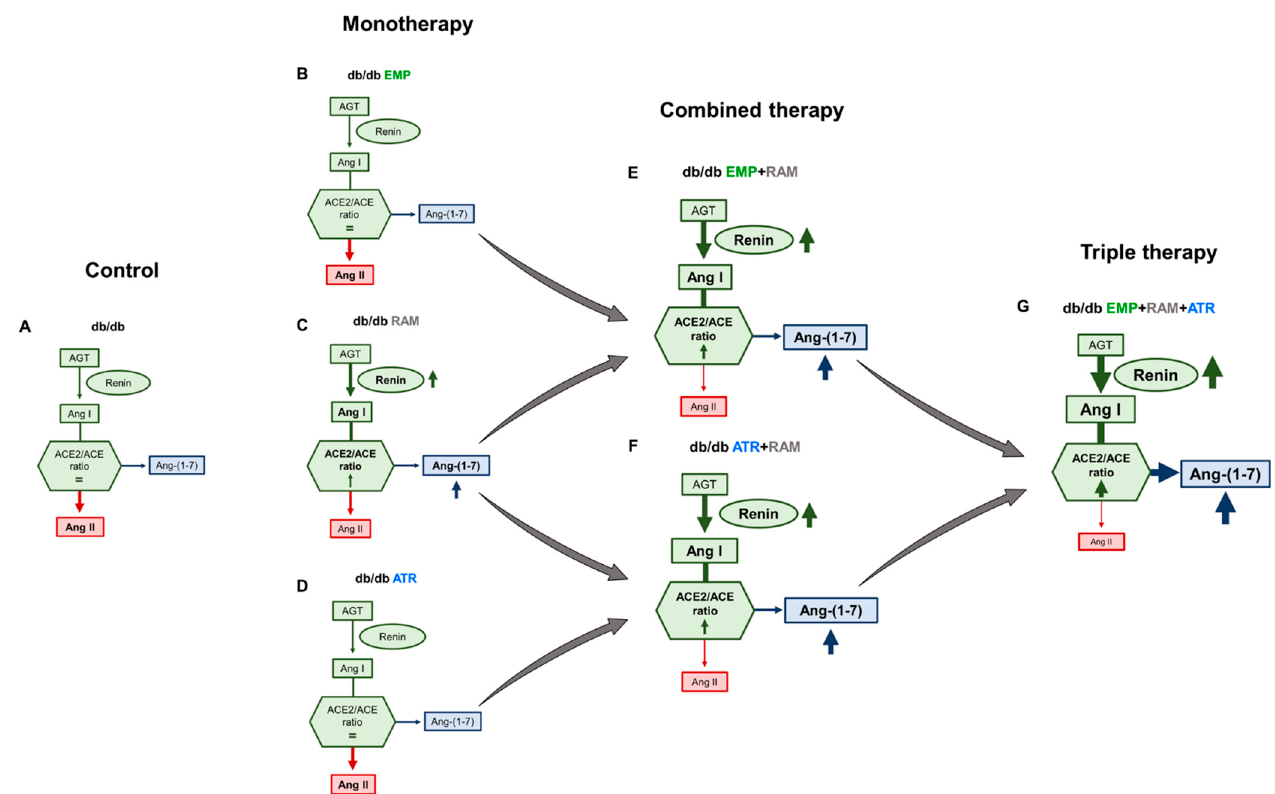
Figure 7. Proposed modulation of intrarenal renin angiotensin system (RAS) in db/db mice treated with empagliflozin, atrasentan, ramipril, or their combination. Treatment with empagliflozin ( B ) or atrasentan ( D ) alone did not significantly change intrarenal RAS but ramipril alone increases kidney renin levels ( C ) when compared to vehicle-treated db/db mice ( A ). However, either empagliflozin or atrasentan combined with ramipril (( E , F ), respectively) increased renin activity and directed the intrarenal RAS towards the Ang (1–7) protective axis. These effects were highest in the combination therapy of empagliflozin, atrasentan and ramipril ( G ). Ang I : angiotensin I. Ang